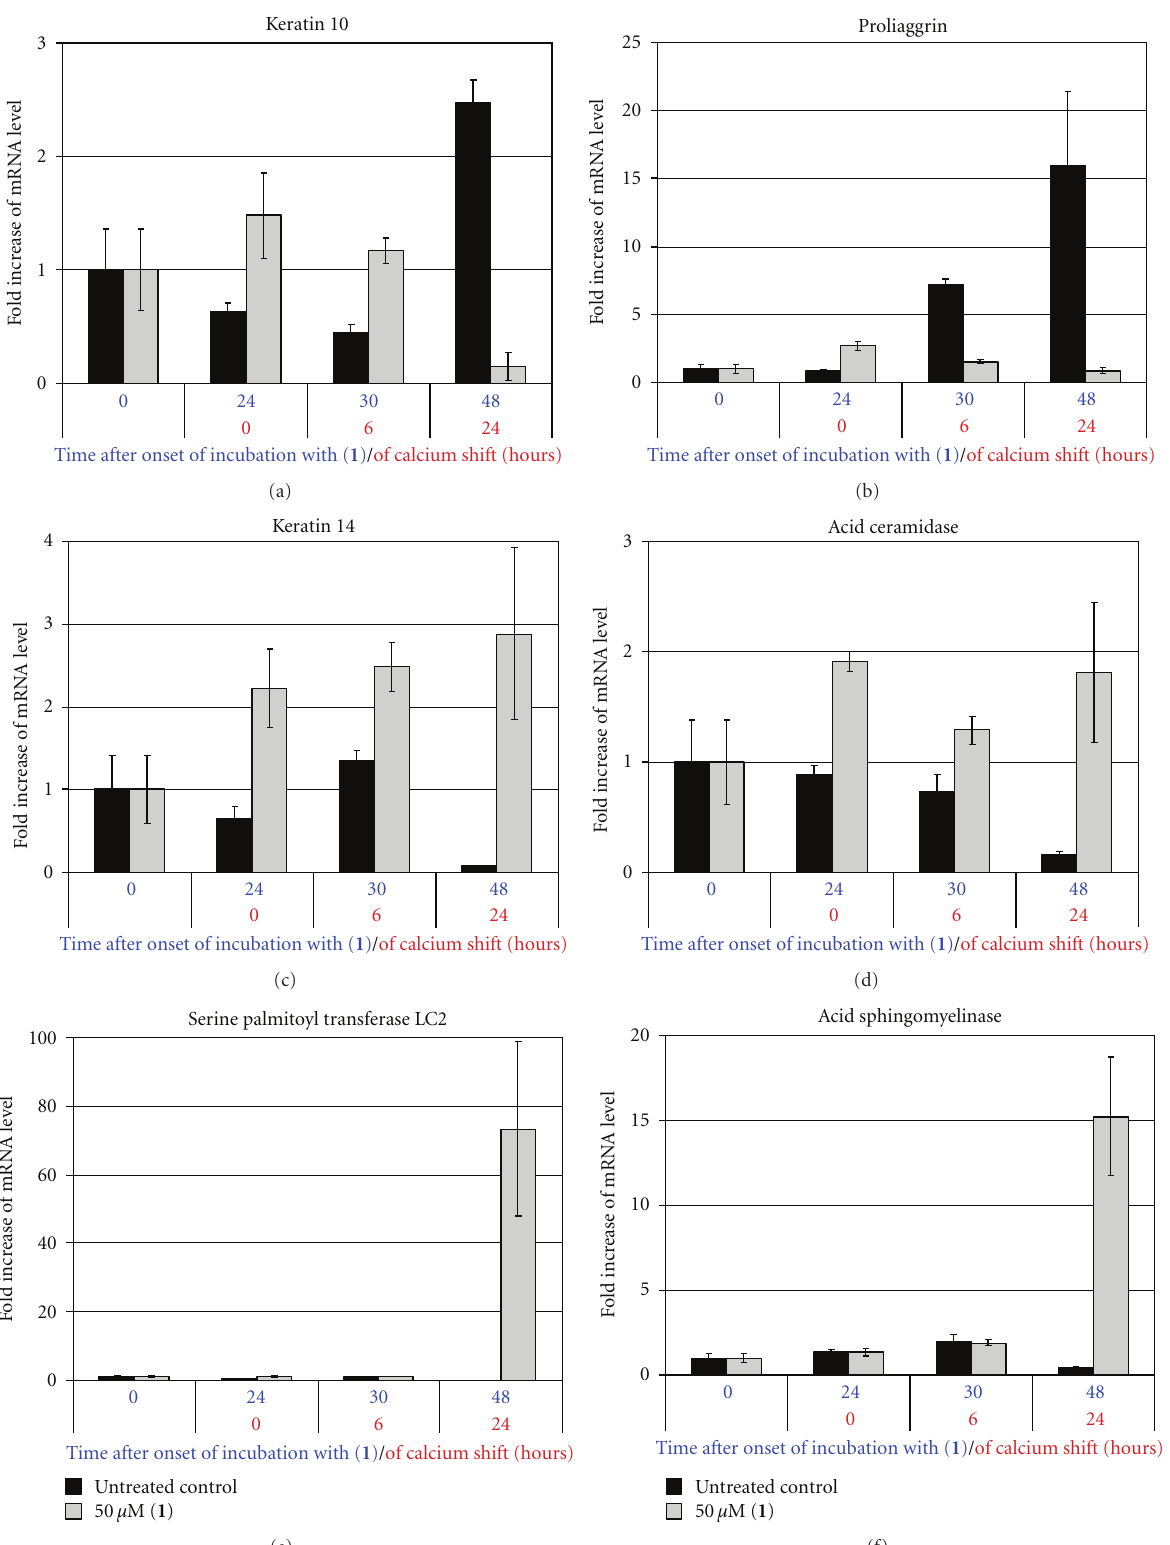
Figure 2: E ff ect of 1 on transcription levels of di ff erentiation markers and enzymes of sphingolipid metabolism in cultured human keratinocytes. Proliferating cells were incubated with 50 μ M of 1 for 24h and were then submitted to a calcium shift to induce di ff